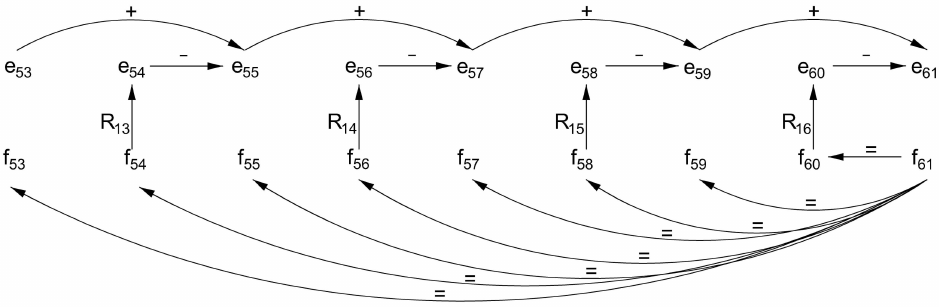
Figure 20. TCG of the